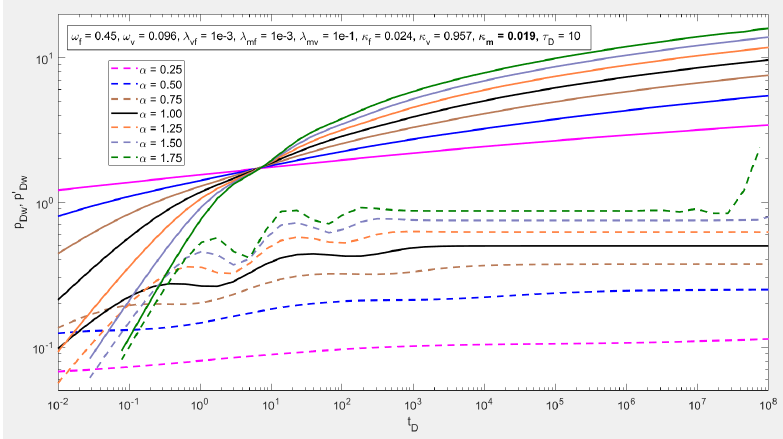
Figure 11. Effects of varying the order on the fractional time derivative considering α = α f = α v = α m with a non-trivial auxiliar constant, i.e., τ D (cid:54) =